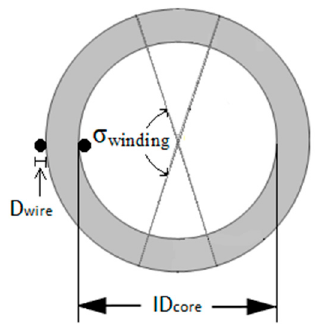
Figure 2. Toroidal core: geometric parameters for Equation (3).